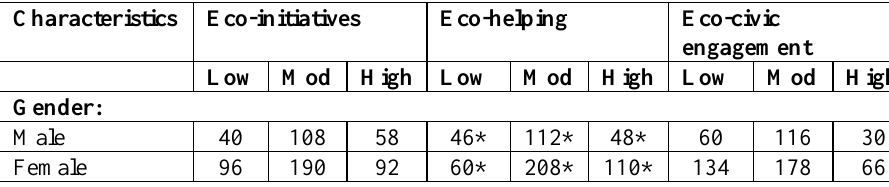
Table 04: Comparison of ECB Extend and Demographic Characteristics (number of students in